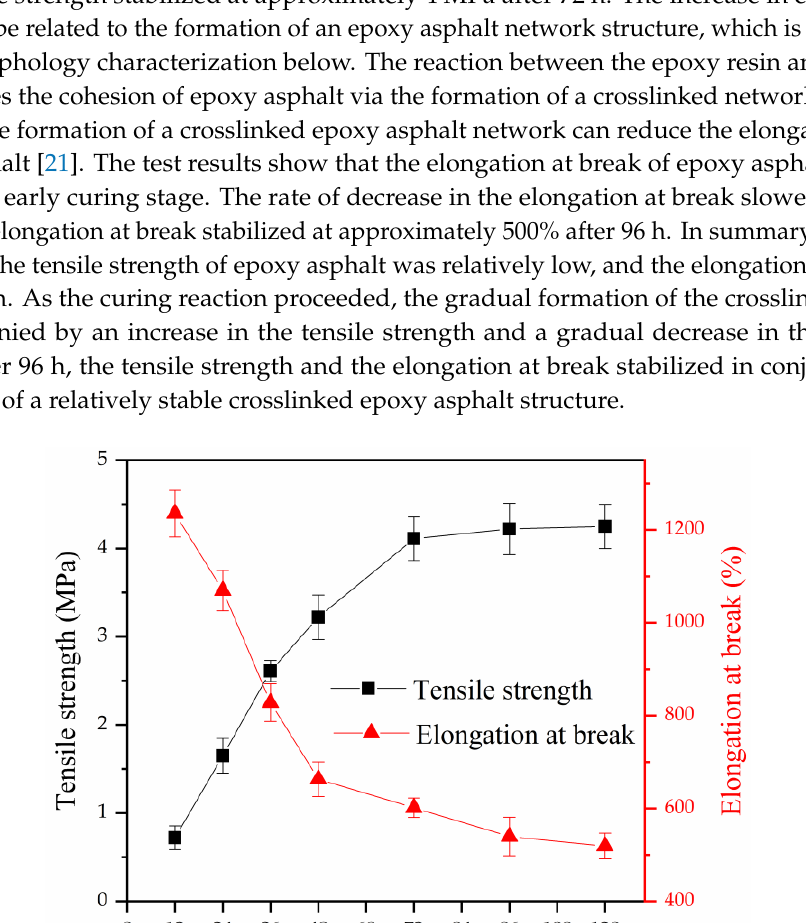
Figure 1. Mechanical properties of epoxy asphalt with different curing times.